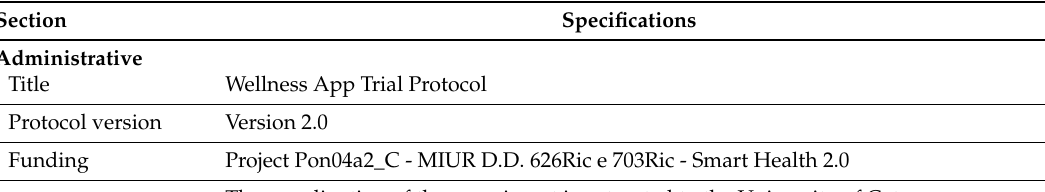
Table 2. Wellness App: Trial